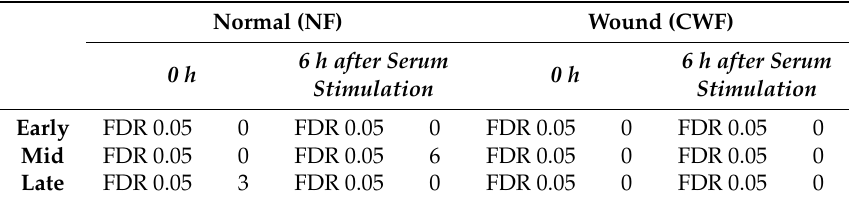
Table 2. Counts of genes identified as significantly different (FDR 0.05).